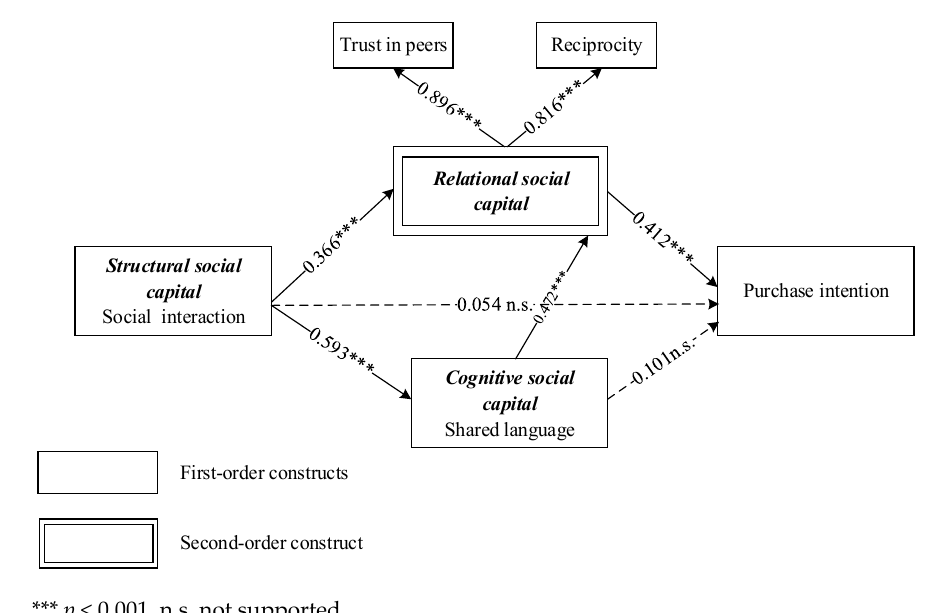
Figure 2. PLS results.